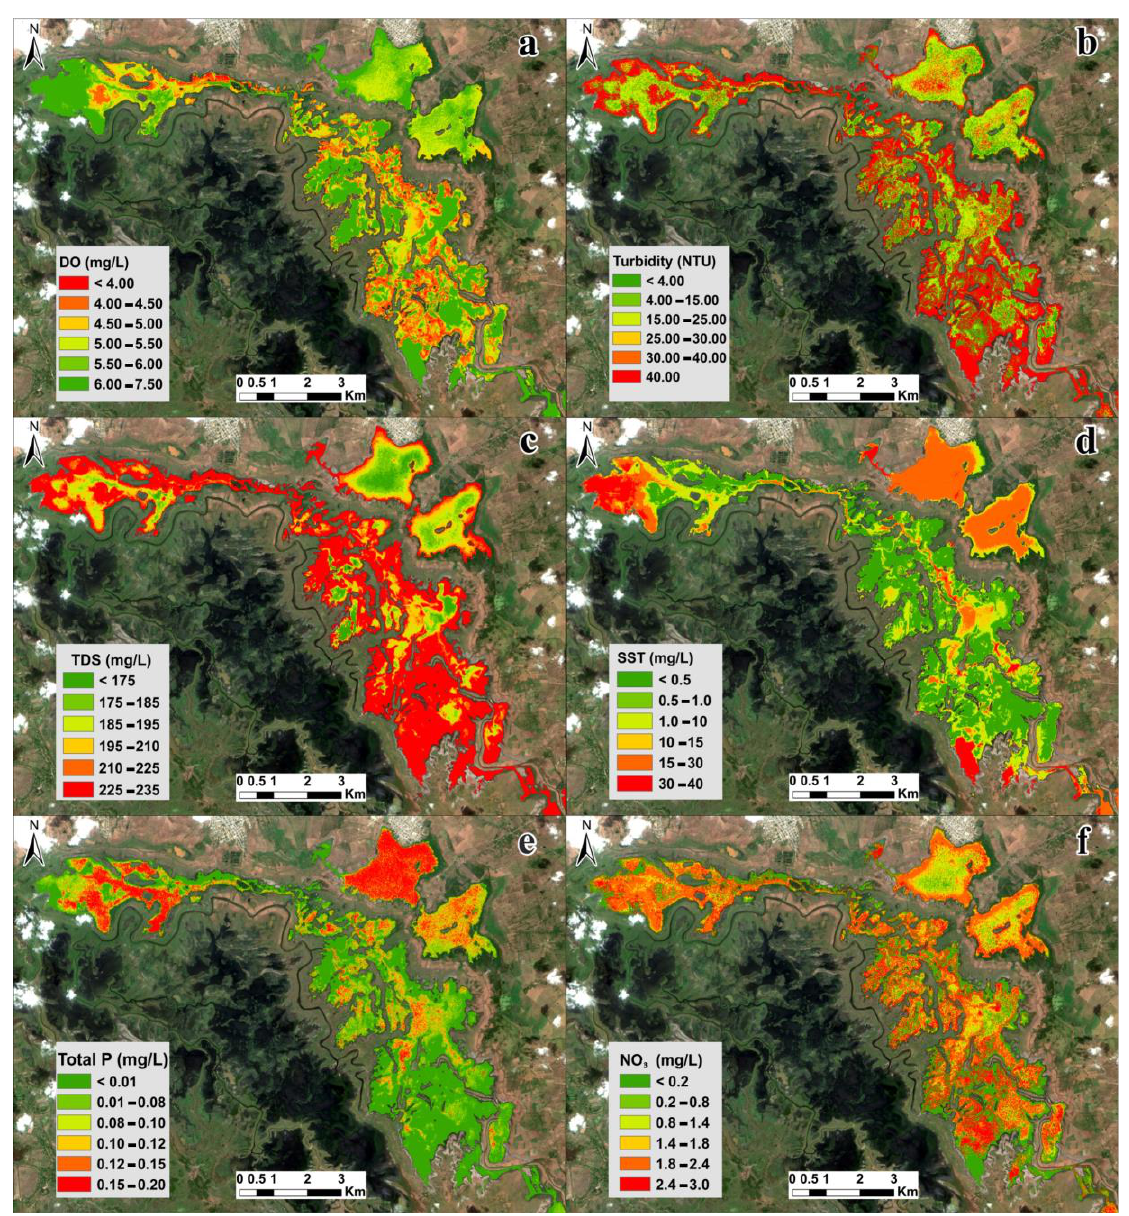
Figure 4. Water quality maps estimated from the models. ( a ) dissolved oxygen (DO); ( b ) turbidity; ( c ) total dissolved solids (TDS); ( d ) total suspended solids (TSS); ( e ) total Phosphorus (TP) and ( f ) nitrates (NO 3 ).